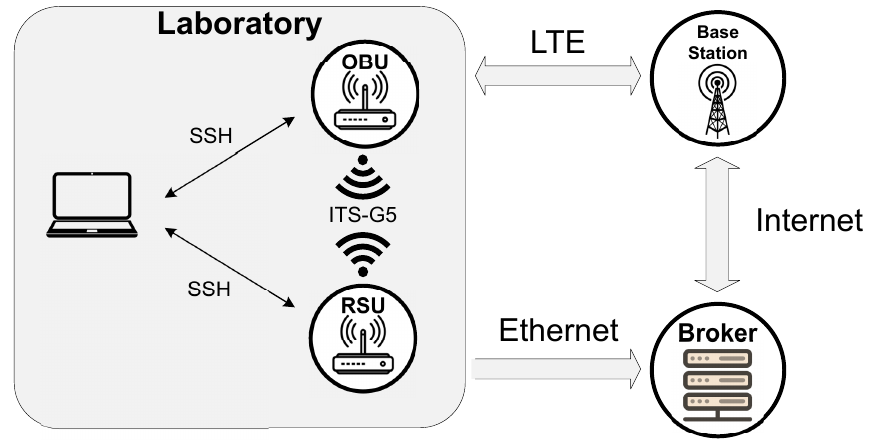
Figure 14. Experimental test setup